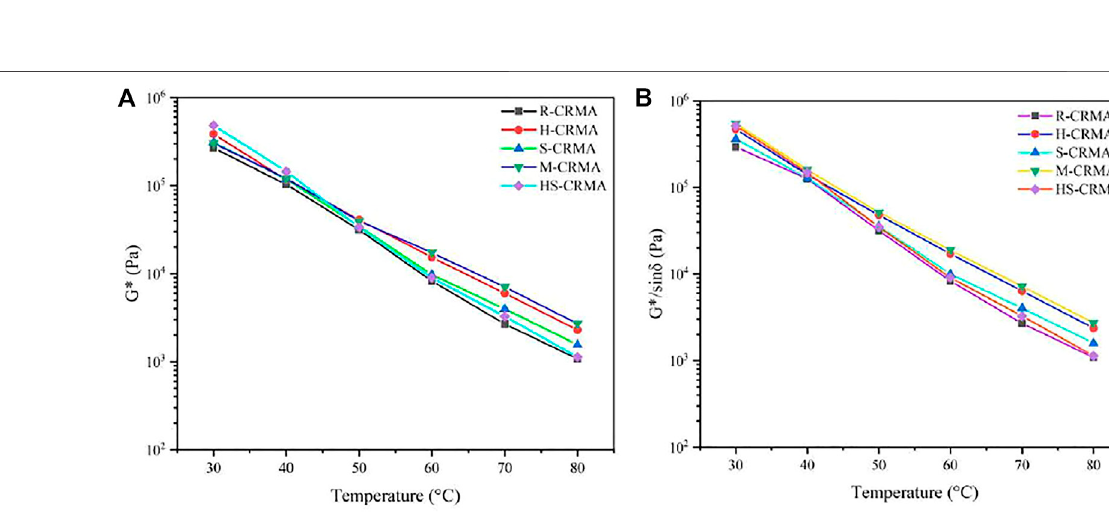
TABLE 3 | The fi tting results for viscosity as a function of temperature.